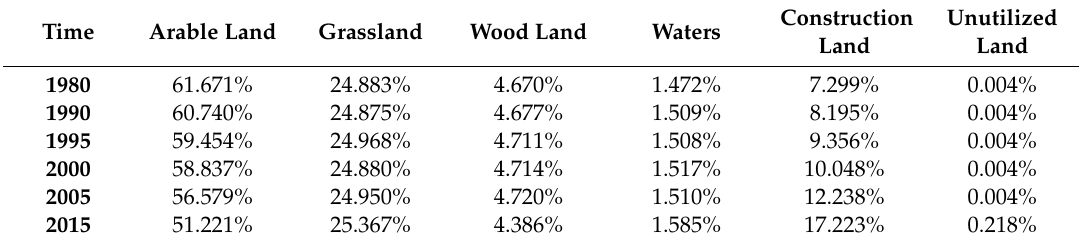
Table 6. Percentages of di ff erent land-use types in Chengdu.